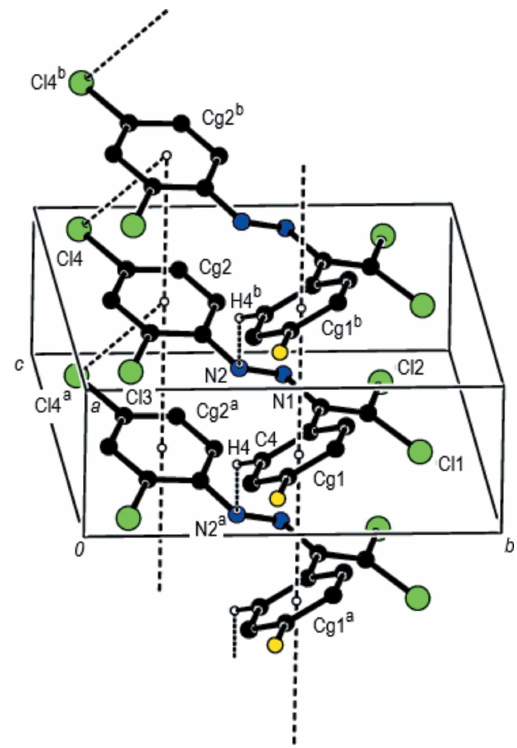
Figure 2 A general view of the intermolecular C—H (cid:2)(cid:2)(cid:2) N and C—Cl (cid:2)(cid:2)(cid:2) (cid:2) interactions and (cid:2) – (cid:2) stacking interactions, shown as dashed lines. Symmetry codes: ( a ) (cid:4) 1 + x , y , z ; ( b ) 1 + x , y , z